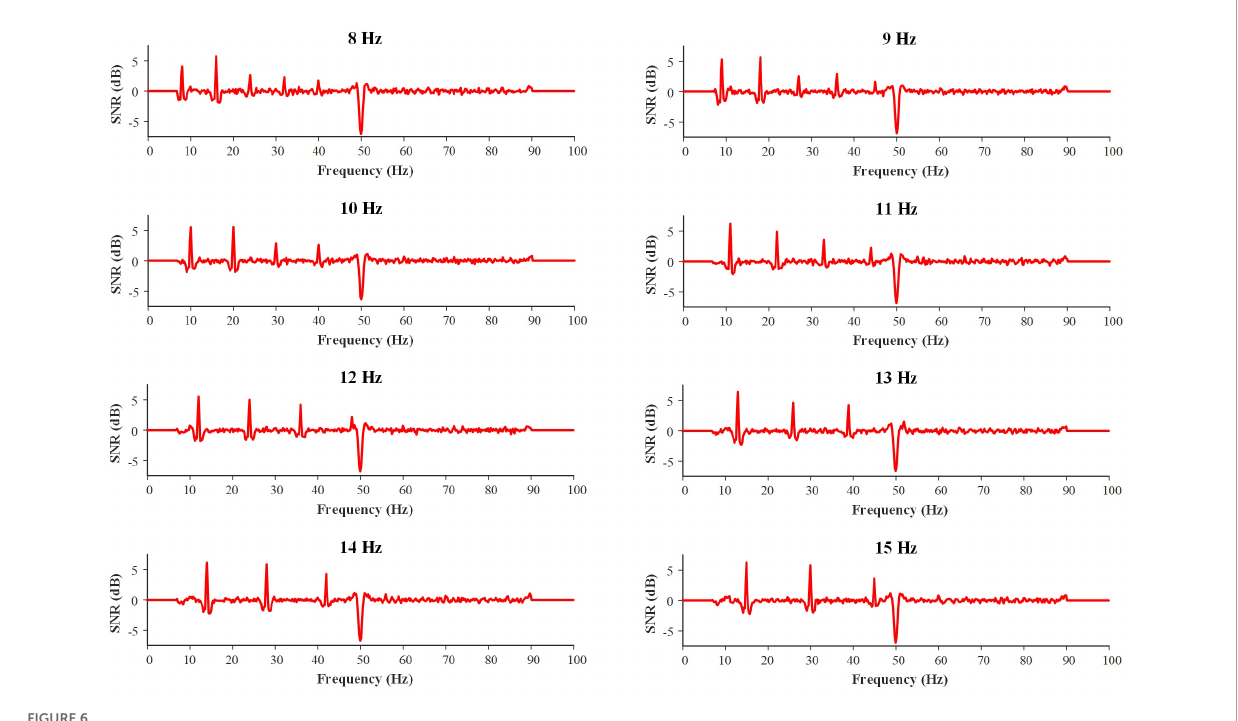
FIGURE6 SNR curves of SSVEPs at all 8 stimulus